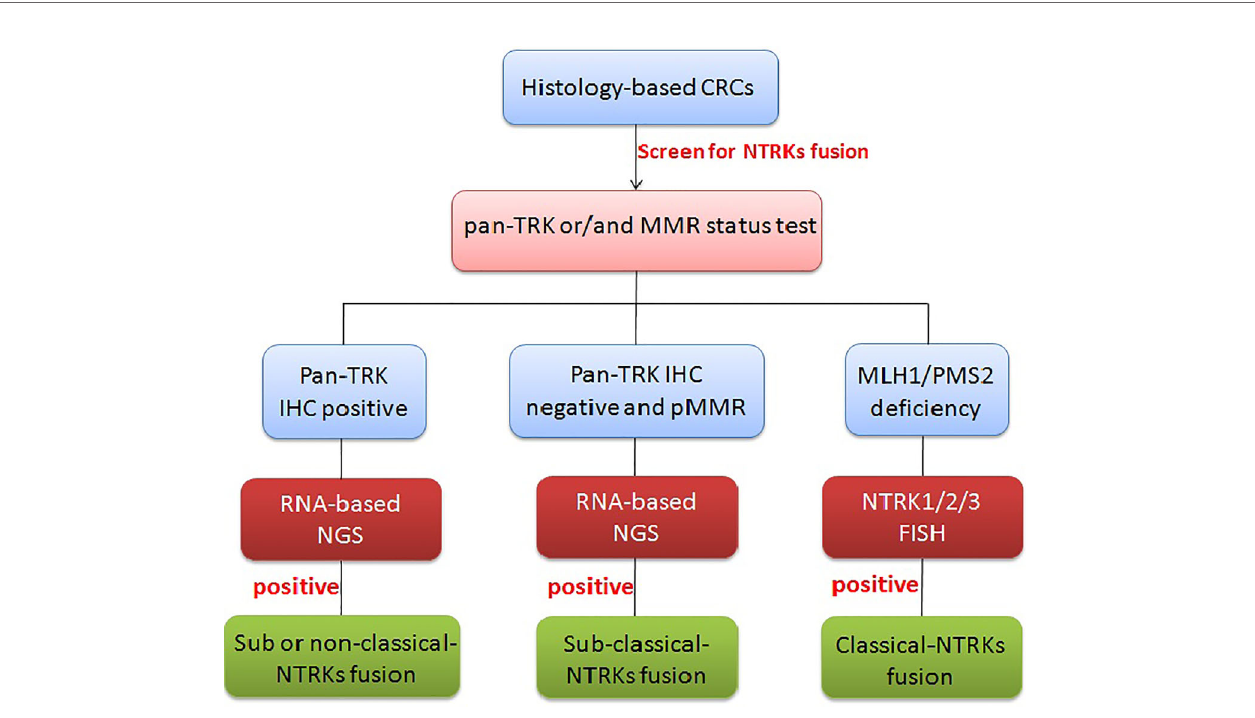
FIGURE 5 | Diagnostic algorithm for NTRK testing in CRCs. In CRCs, pan-TRK IHC as the primary screen tool and MMR IHC can be used as an initial screen, but if pan-TRK IHC positive or/and MLH1/PMS2 de fi ciency, further FISH/NGS should be undergone to con fi rm. MLH1/PMS2 de fi ciency with FISH positive usually means classical NTRK fusions. If neither of pan-TRK IHC positive nor MMR de fi ciency, RNA-level fusion testing should further be used to select the sub-classical NTRK